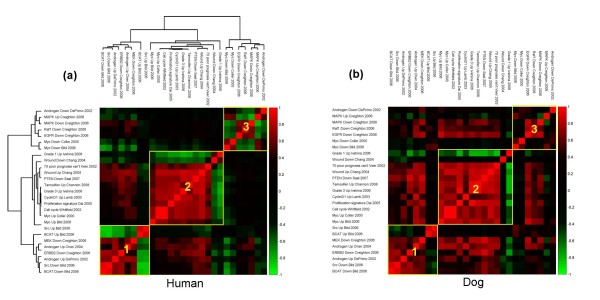
Correlation between prognostic and oncogenic signatures. Heat map representation of the pair wise Pearson's correlations between a selection of "oncogenic" and "prognostic" signatures described in Table 1. (a) Hierarchical clustering of signatures based on the pair wise correlation in human tumor samples. (b) Pair wise Pearson's correlations in the dog tumor dataset are represented. Signatures are ordered as in (a). In yellow are highlighted the three major clusters of correlated signatures described in the text.